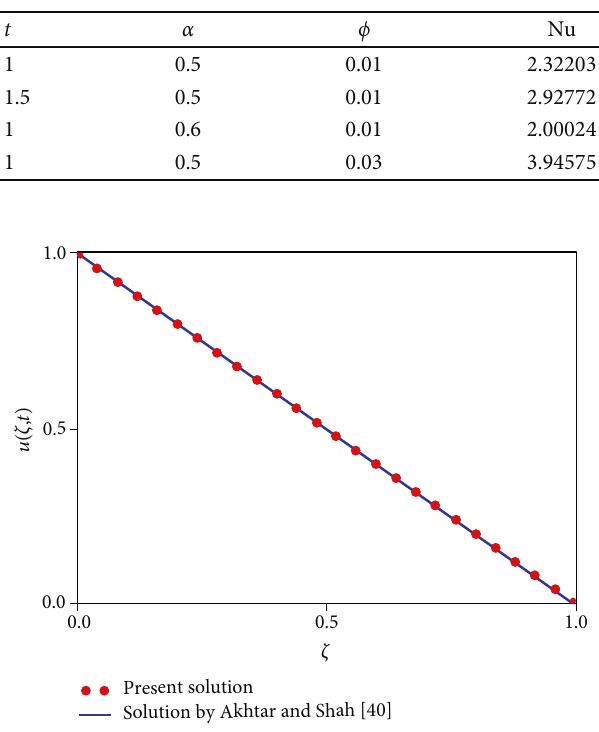
Table 3: The e ff ect of di ff erent parameters on Nu